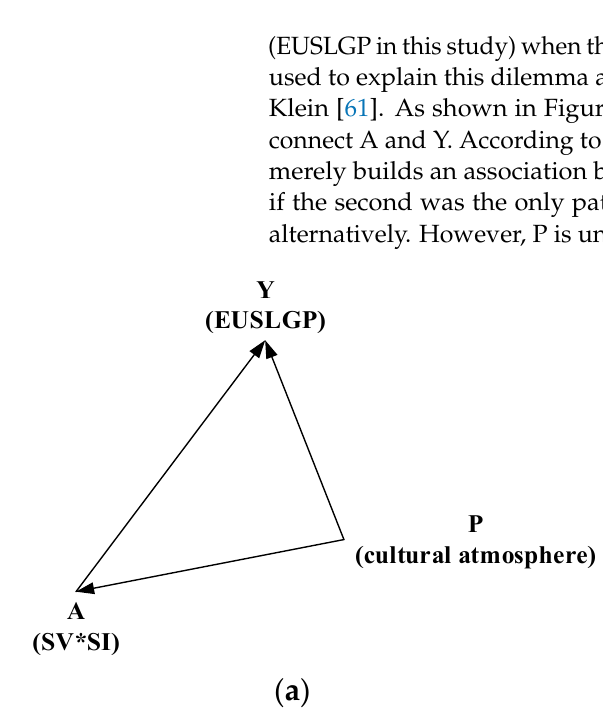
Figure 2. Directed acyclic graphs showing the effects of ( a ) confounder and ( b ) instrumental variable. An instrumental variable (IV) is useful to estimate the correct causal effect of A on Y. In this study, DGRF was selected as an IV for social interaction, and the